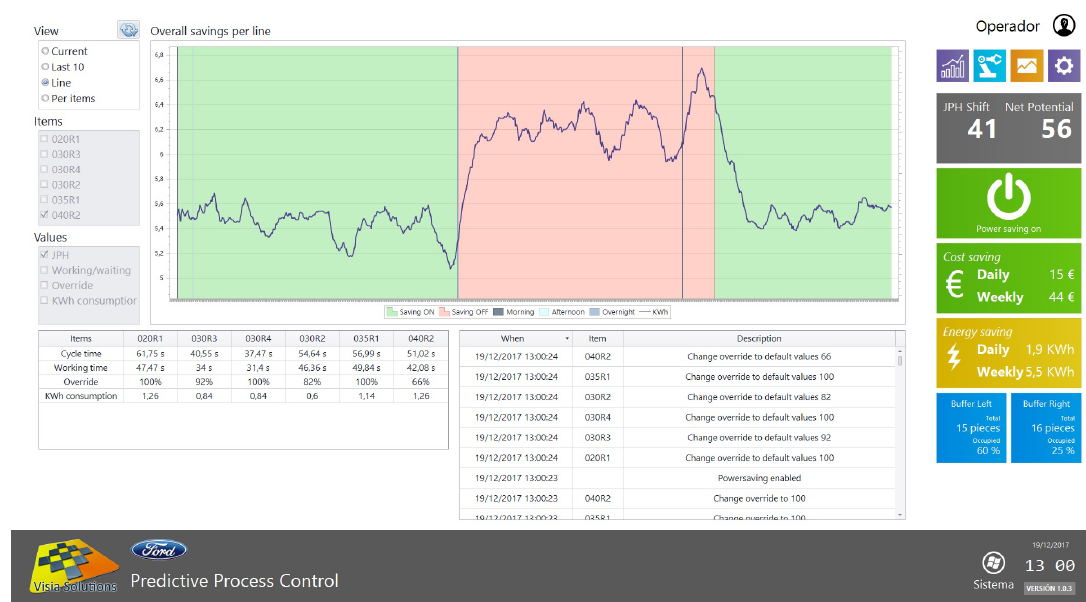
Figure 14. Miniterm 4.0 energy